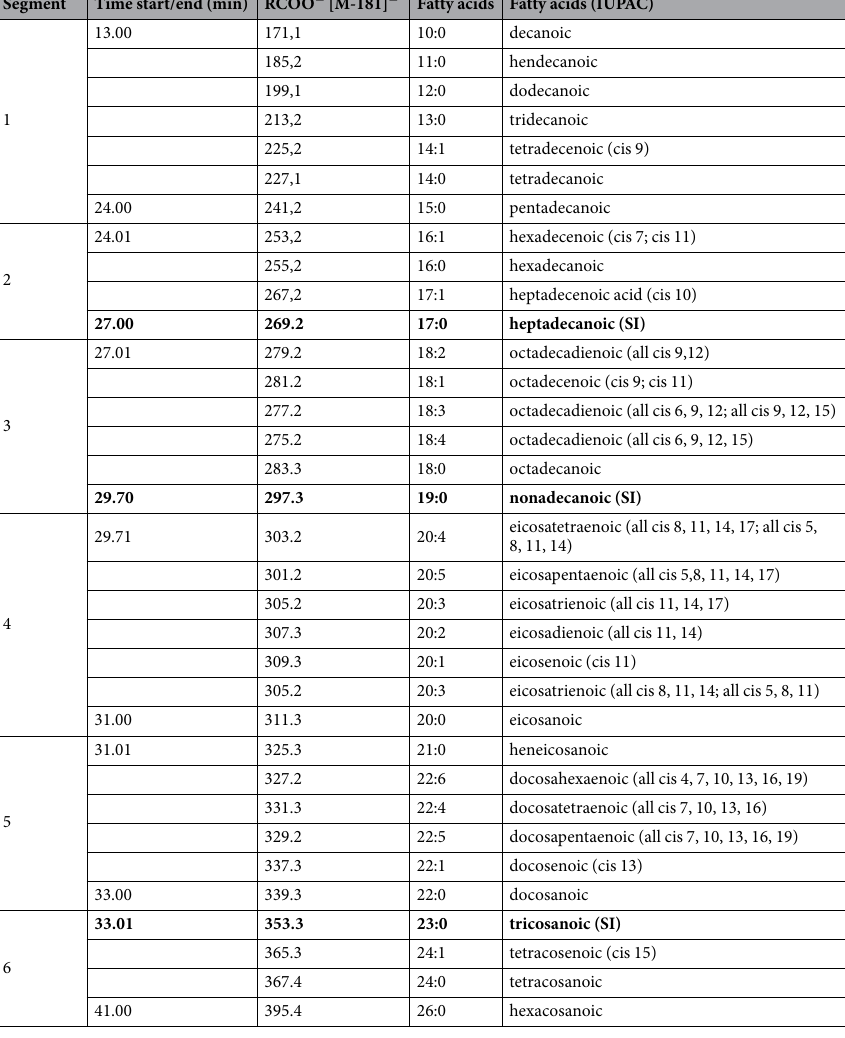
Table 1. Chromatogram segments containing 4 to 7 carboxylate Ions [RCOO-] used in selected ion monitoring (SIM) for quantification of listed fatty